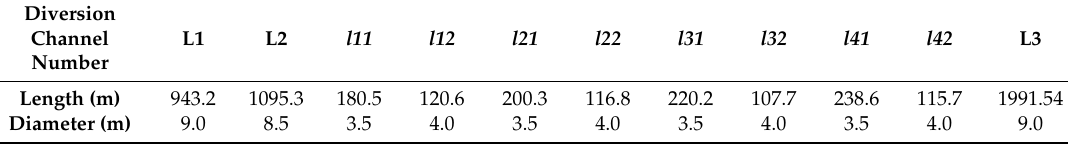
Table 2. Pressure diversion channel parameters of power station.